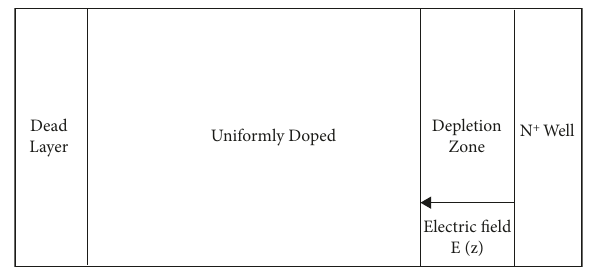
Figure 2: Electric field distribution model for uniform doping of electron multiplication layer.